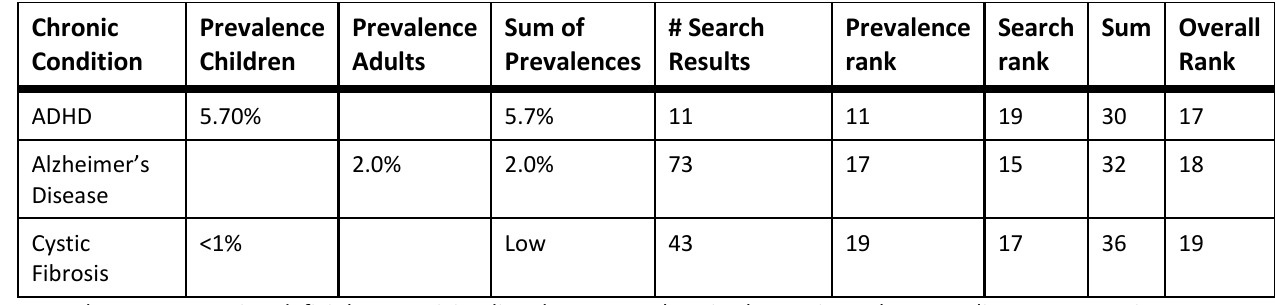
Legend: ADHD=attention deficit hyperactivity disorder, COPD=chronic obstructive pulmonary disease, AD=anxiety